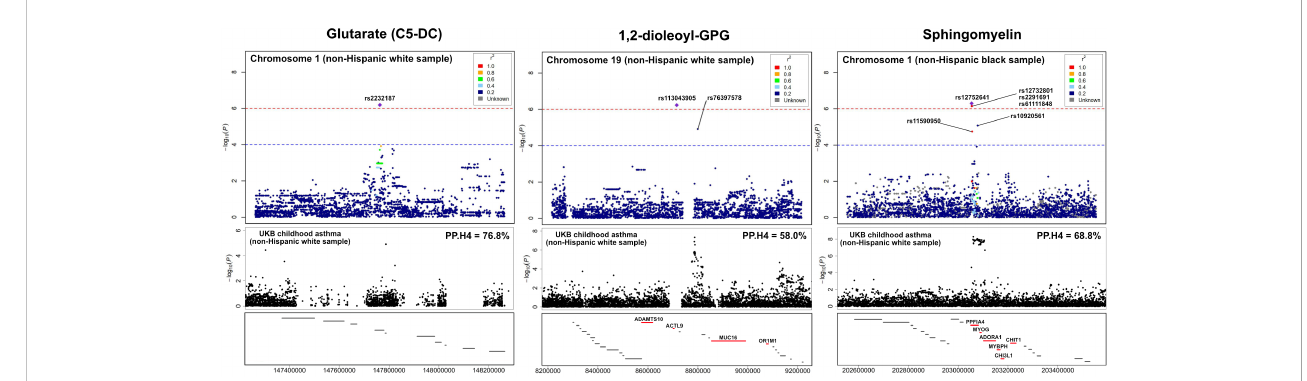
FIGURE 4 LocusZoom for the genetic loci with the UK Biobank summary statistics of childhood asthma To compare the association peaks of the loci between the mtQTL analysis in infants with bronchiolitis and the UK Biobank summary statistics for childhood asthma, we applied LocusZoom to glutarate (C5-DC: glutarylcarnitine) on chromosome 1q21, 1,2-dioleoyl-GPG on chromosome 19p13, and sphingomyelin [d17:1/16:0, d18:1/15:0, d16:1/17:0] on chromosome 1q32. The association peaks of these three loci were aligned with those in the same genetic regions of UK Biobank summary statistics for childhood asthma. The red lines at the bottom boxes represent the genetic location of the genes that are known to be related to asthma. There were concordances between the association peaks of two loci (i.e., chromosome 19p13 with 1,2-dioleoyl-GPG, chromosome 1q32 with sphingomyelin) and known asthma genes (e.g., ADORA1 , MUC16 ). Abbreviations: GPG, glycero-3-phosphoglycerol; PP.H4, posterior probability of hypothesis 4; UKB, UK